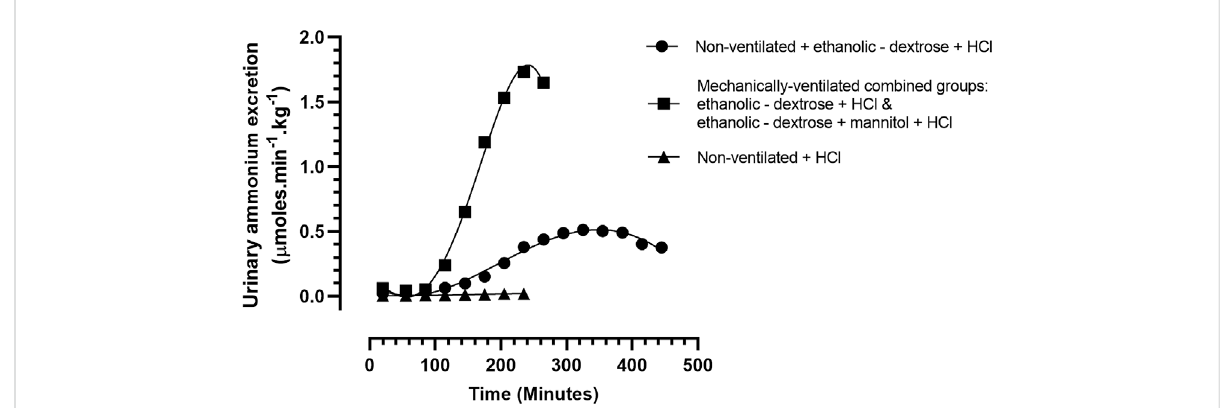
FIGURE 2 Urinaryammoniumexcretionrate,inrabbitstreatedaccordingtoProtocols1 – 4:Protocol1(N=9):0.9%NaCl+0.1MHCL,non – mechanically ventilated.Protocol2(N=5):Ethanolic - dextrose+0.1MHCl,non – mechanicallyventilated(N=5).Protocols3+4(N=10):4rabbitsadministered ethanolic - dextrose + 0.1 M HCl and 6 rabbits administered ethanolic – dextrose + mannitol + 0.1 M HCl, both groups mechanically ventilated.